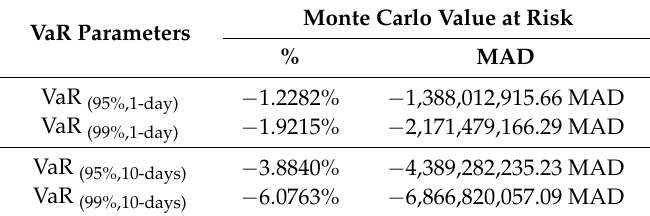
Table produced on Excel under VBA by the